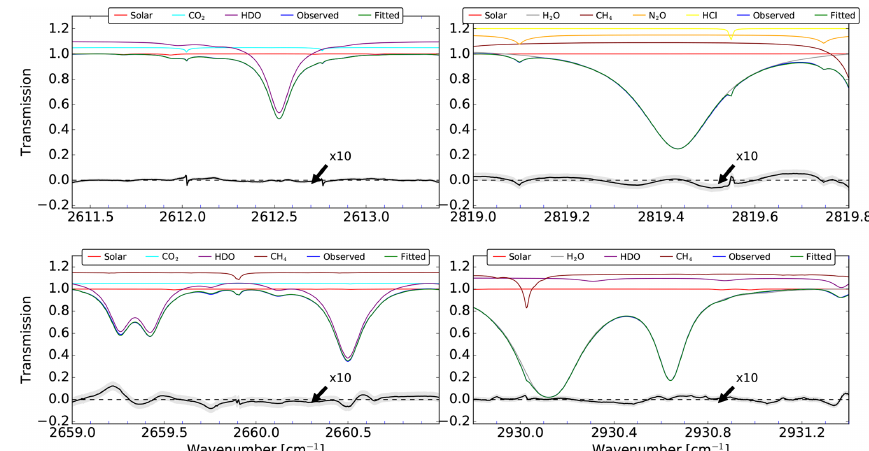
Figure 1. Mean retrieval fit between 2010 and 2016 for the spectral intervals of WV. The observed and fitted lines are blue and green, respectively. The absorption contribution for the different species is also shown in each micro-window. The bottom black lines represent the mean residual and the gray shadow is the standard deviation. Note that for visibility the residuals have been multiplied by 10.